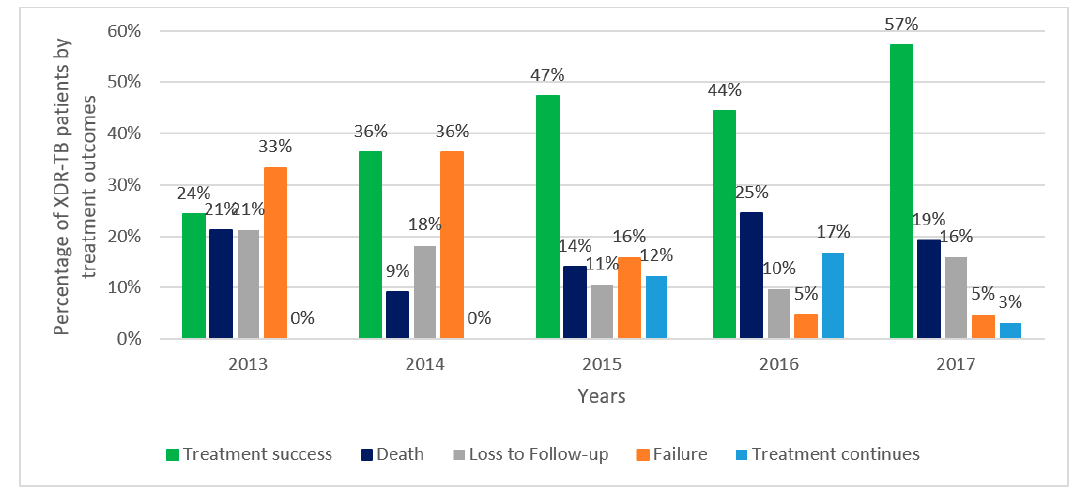
Figure 3. Treatment outcomes of XDR-TB patients enrolled in XDR-TB treatment in Uzbekistan between 2013 and 2017. TB = tuberculosis; XDR-TB = extensively drug resistant TB; Treatment continues = treatment continues up to and after surgery.